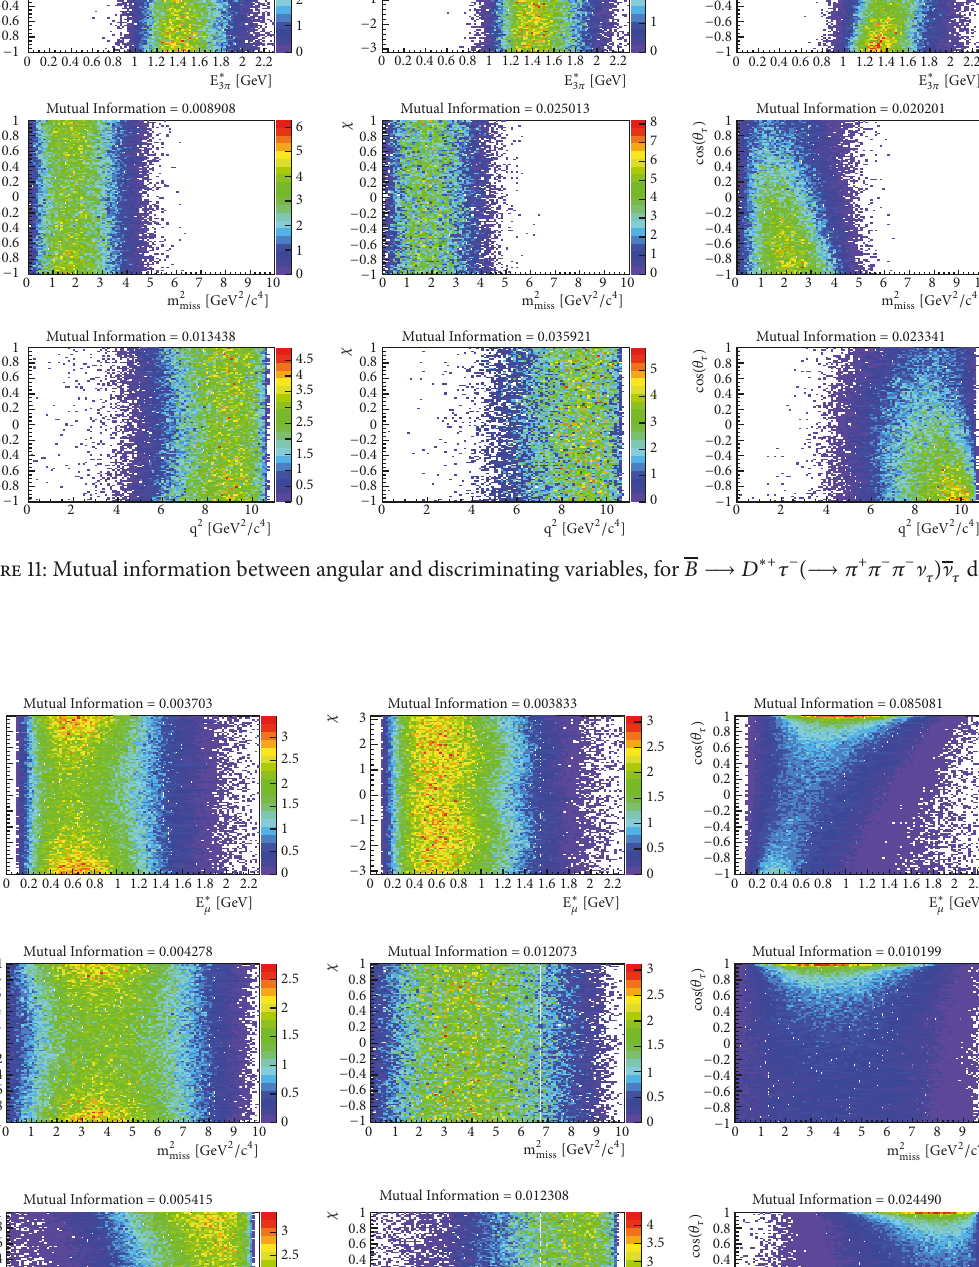
Figure 12: Mutual information between angular and discriminating variables, for 𝐵 󳨀→ 𝐷 ∗+ 𝜏 − (󳨀→ 𝜇 − ] 𝜇 ] 𝜏 ) ] 𝜏